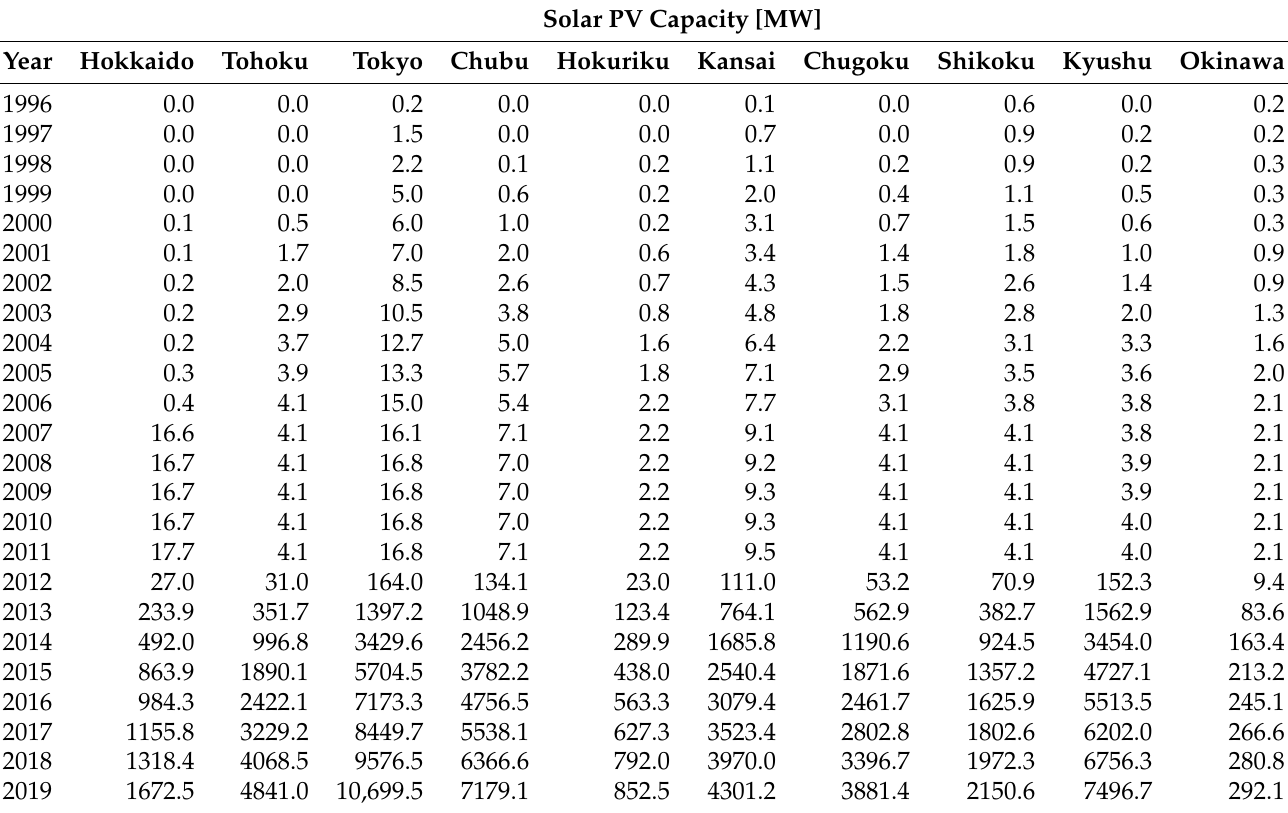
Table A4. Cumulative Commercial Solar PV Capacity